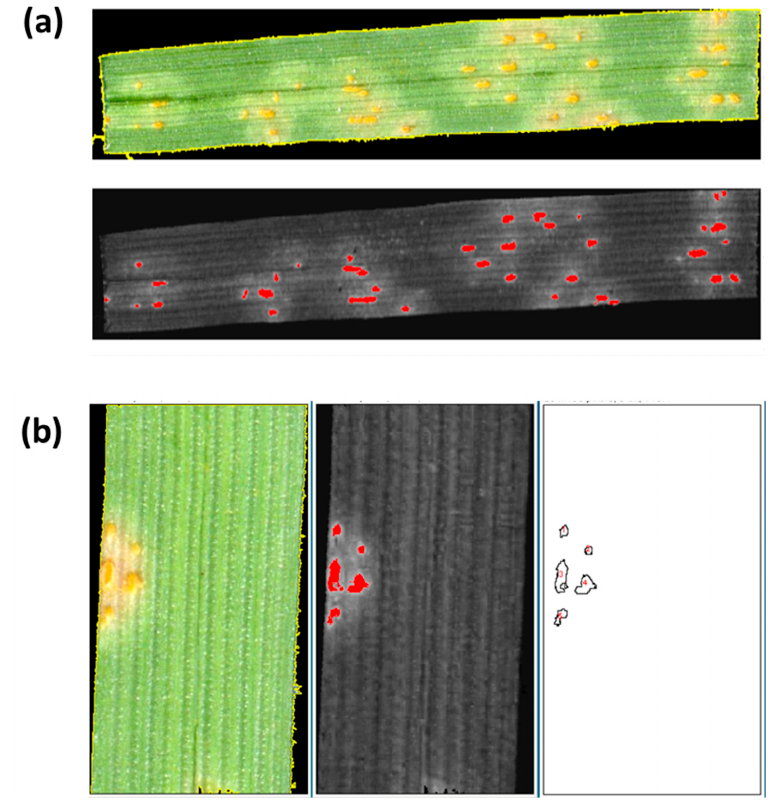
Figure 3. Discrimination of pustules from healthy tissue by RUST script. ( a ) Detection of primary rust pustules. ( b ) Detection and counting of a ring of secondary pustules surrounding a primary pustule.